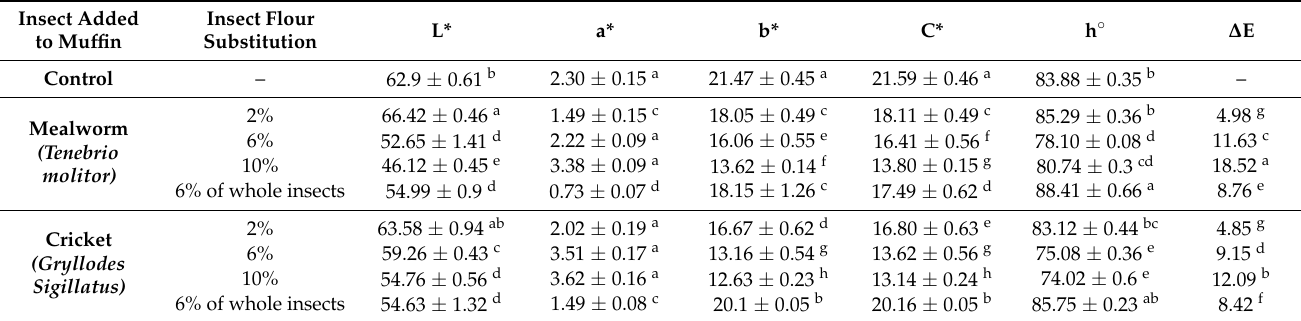
Table 2. Color determinants of muffins.